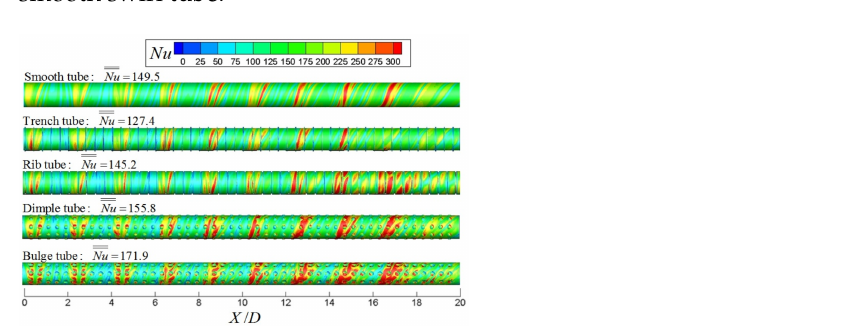
Figure 7. Comparisons of the local Nusselt number with different surface structures on the swirl tube wall with nine jets at Re D =